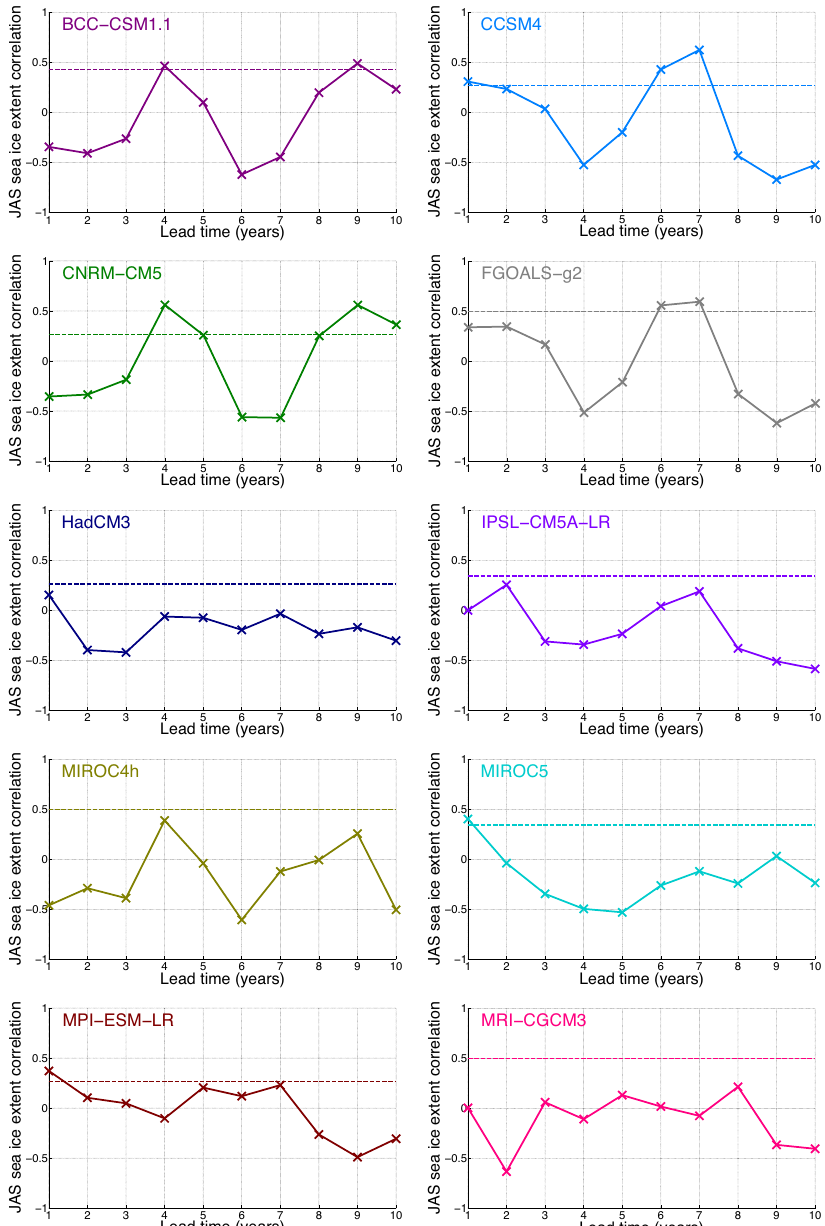
Fig. 7. Correlation between Southern Ocean winter (JAS) sea ice extent in models results and observations. For each model the correlation is computed from a series of 4 hindcasts ensembles, initialized every 5yr between January 1981 and January 1996 (between November 1980 and November 1995 for HadCM3). In each plot the dashed line refers to the 95% significance